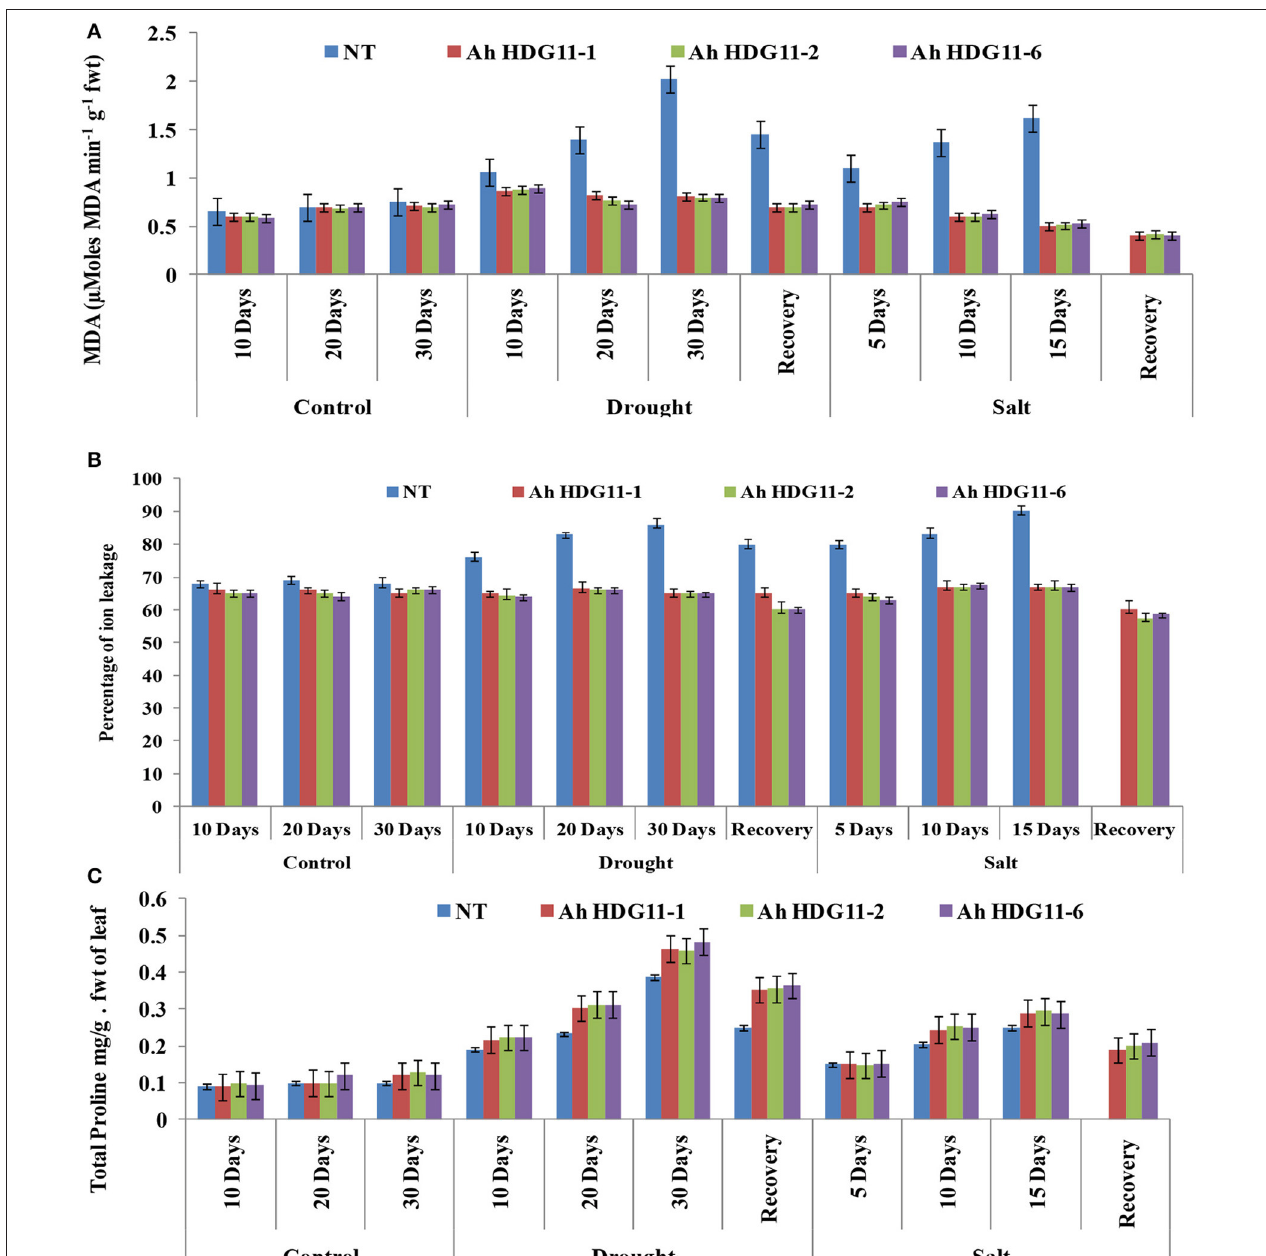
FIGURE 9 | Biochemical analysis of transgenic lines AhHDG11-1, AhHDG11-2, AhHDG11-6 along with the Non-transgenic (NT) plants. (A) Malondialdehyde (MDA) (B) Percentage of ions leakage (C) Proline (Pro).